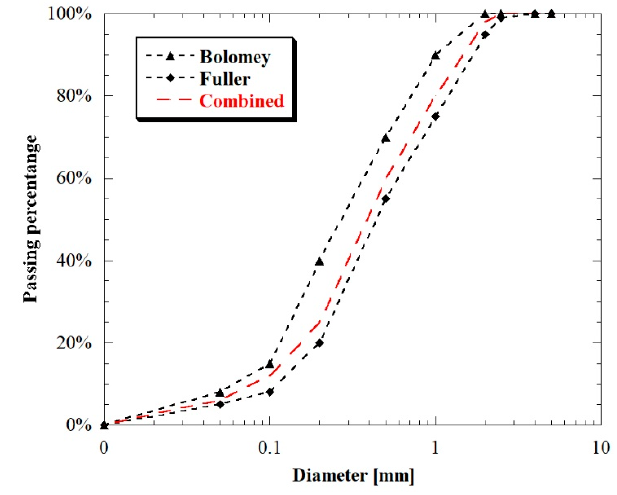
Figure 1. Granulometry of aggregates.